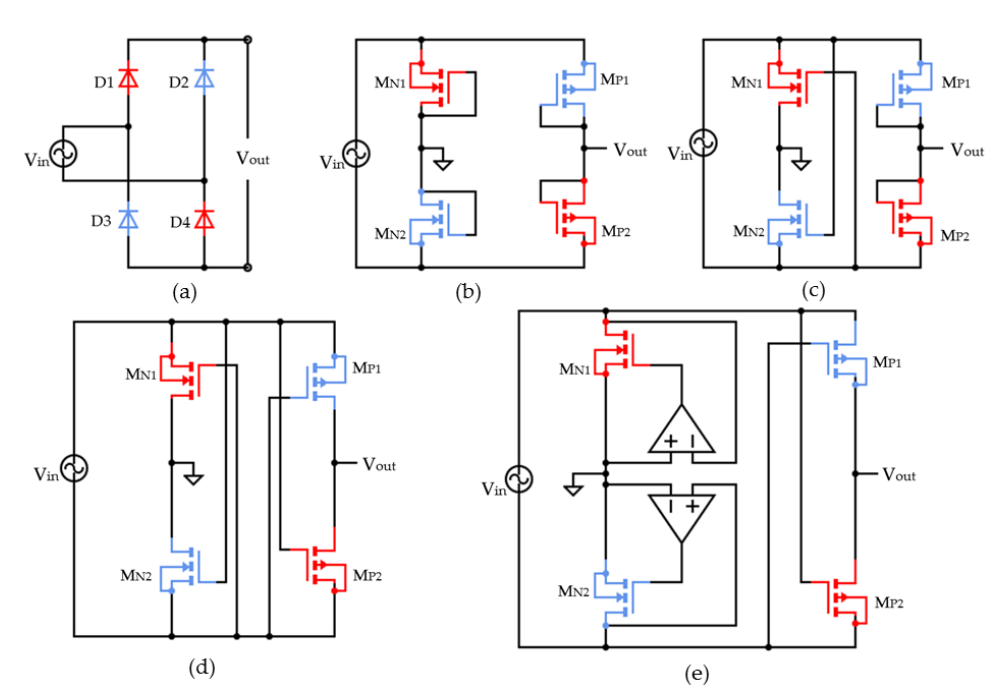
Figure 4. AC-DC rectifiers for SSHI interfaces: ( a ) Diode Bridge, ( b ) MOSFET Bridge (2N & 2P), ( c ) GCCR (2N & 2P), ( d ) NVC (2N & 2P), ( e ) Active Rectifier with Cross-Coupled PMOS Switches (2N & 2P)